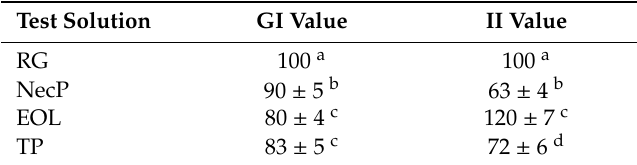
Table 4. Glycaemic index (GI) and insulinemic index (II) for the three treatment beverages. TB NecP (2 g of NecP, equivalent to 14 µ g ABA), TB EOL (400 mg EOL, equivalent to 60.0 mg oleuropein), TB TP (2 g TP, equivalent to 1.0 mg total carotenoids) in relation to the reference glucose solution (RG). Test Solution GI